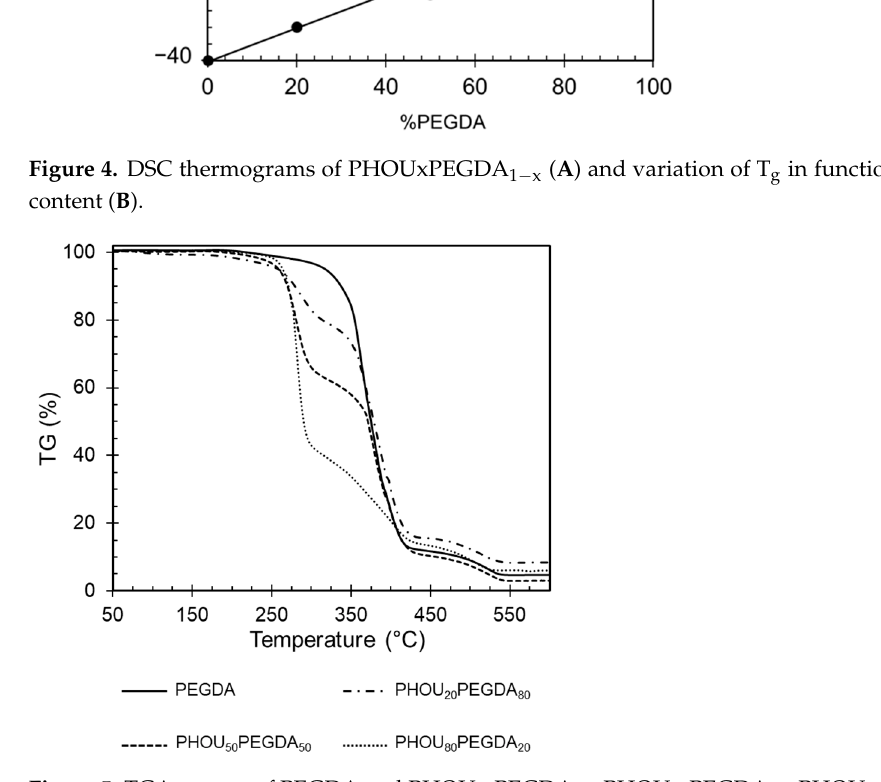
Figure 5. TGA spectra of PEGDA and PHOU 20 PEGDA 80 , PHOU 50 PEGDA 50 , PHOU 80 PEGDA 20 .